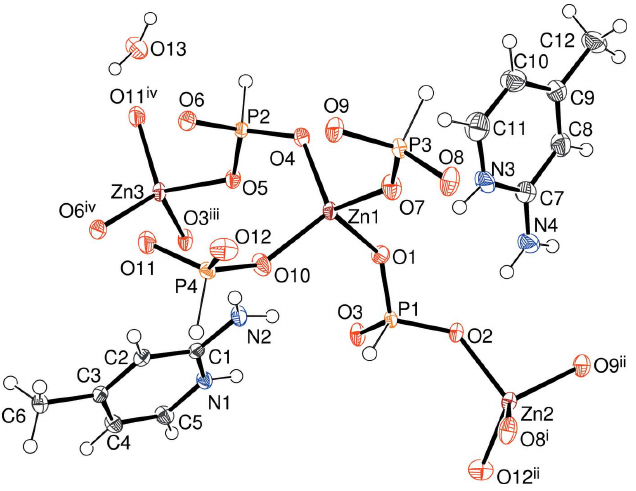
Figure 4 The asymmetric unit of (IV) expanded to show the complete zinc-atom coordination sphere showing 50% displacement ellipsoids. Symmetry codes: (i) (cid:5) x , 1 (cid:5) y , 1 (cid:5) z ; (ii) x (cid:5) 1, y , z ; (iii) (cid:5) x , 1 (cid:5) y , (cid:5) z ; (iv) 1 (cid:5) x , 1 (cid:5) y , (cid:5) z .